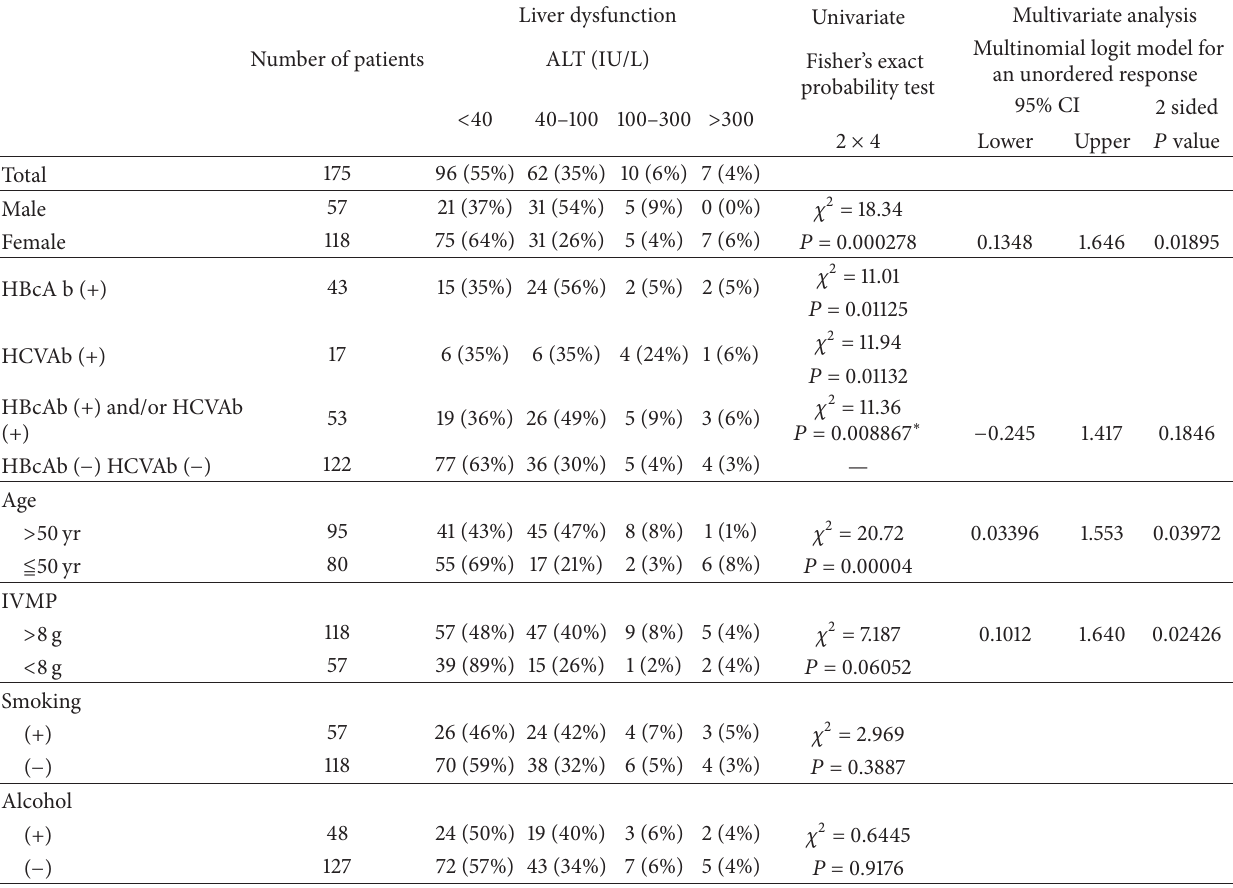
Table 2: Risk factors associated with liver dysfunction during and/or after intravenous methylprednisolone pulse therapy for Graves’